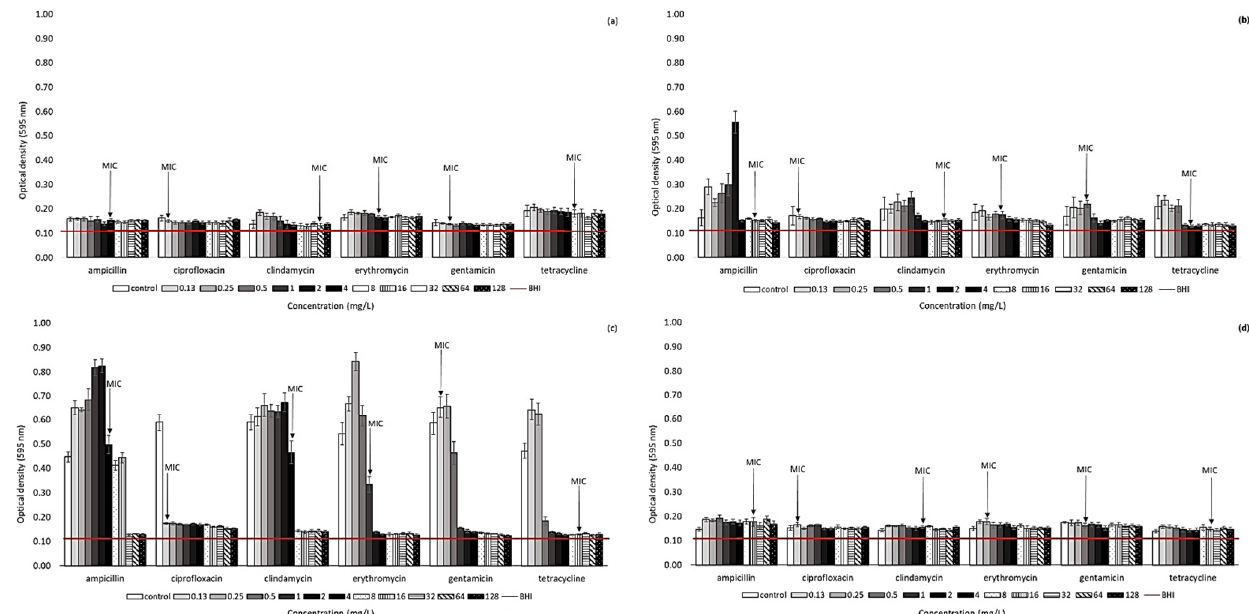
Figure 2. Biofilm formation in the presence of antibiotics. ( a ) Aliarcobacter cryaerophilus CCM 7050; ( b ) Aliarcobacter cryaerophilus UPa 2013/13 (isolated from water); ( c ) Pseudarcobacter defluvii LMG 25694; ( d ) Aliarcobacter skirrowii LMG 6621. The horizontal line represents the influence of BHI broth (values under horizontal line—biofilm-negative; values above line—biofilm-positive).